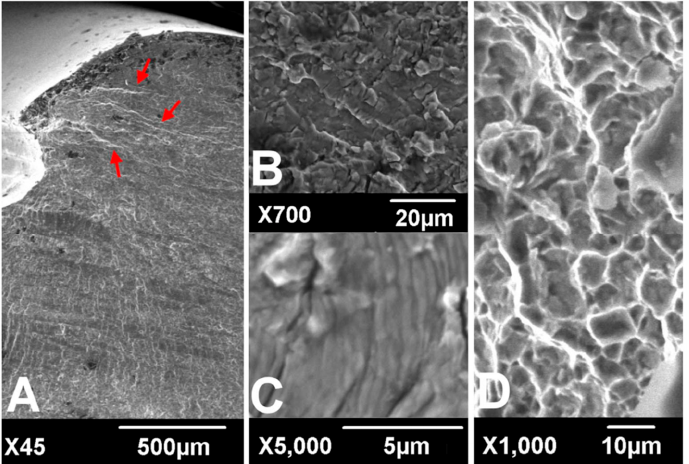
Figure 1. Scanning electronic microscopic findings of fracture surfaces. River marks (red arrows) originate from the thread crest ( A ). Transgranular cracking ( B ) with striations perpendicular to the river marks ( C ) was observed at the crack propagation zone. Dimpled ductile fractures were observed at the overload zone ( D ). (according to [6]).